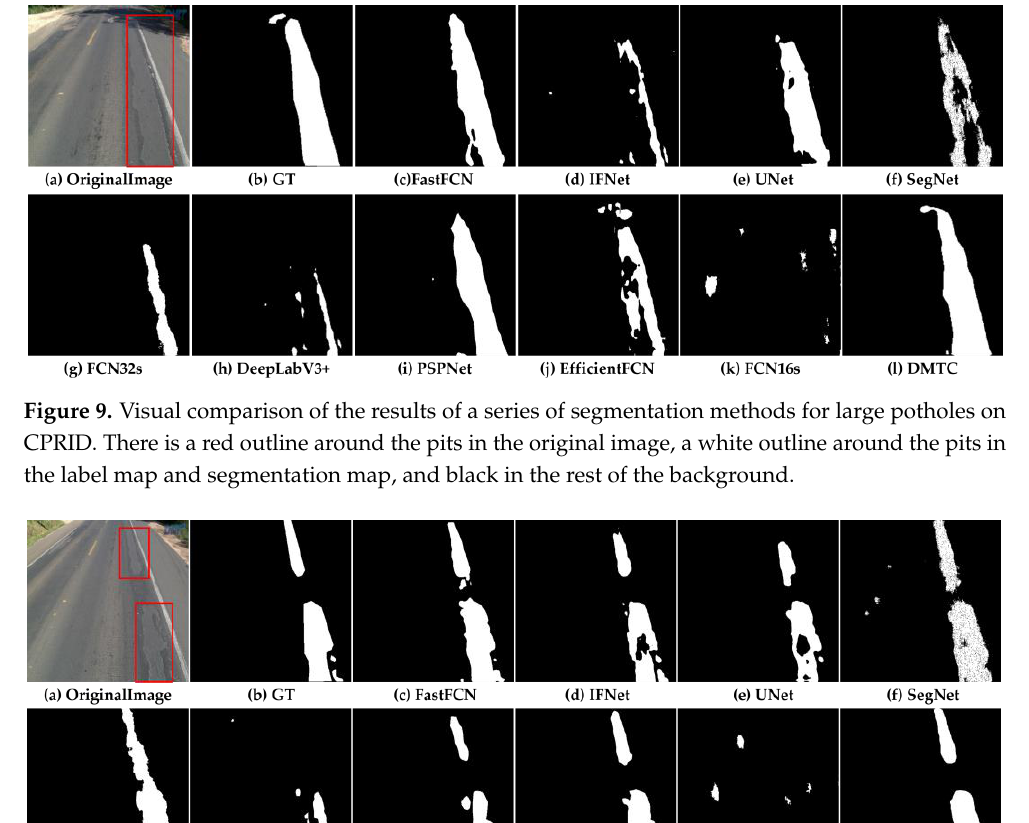
pits in the label map and segmentation map, and black in the rest of the background.